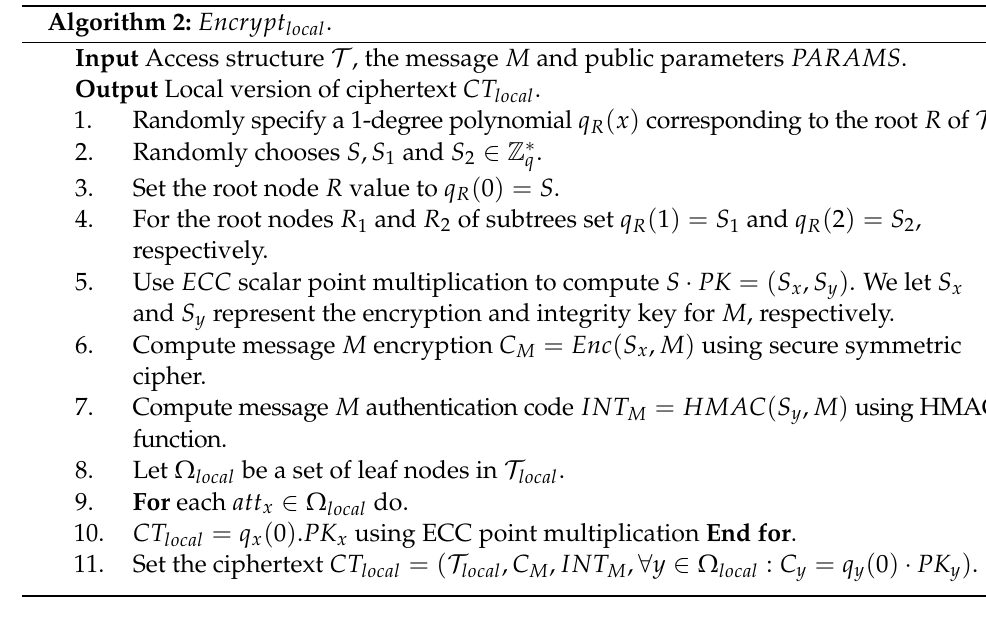
Algorithm 3: Encrypt ESP